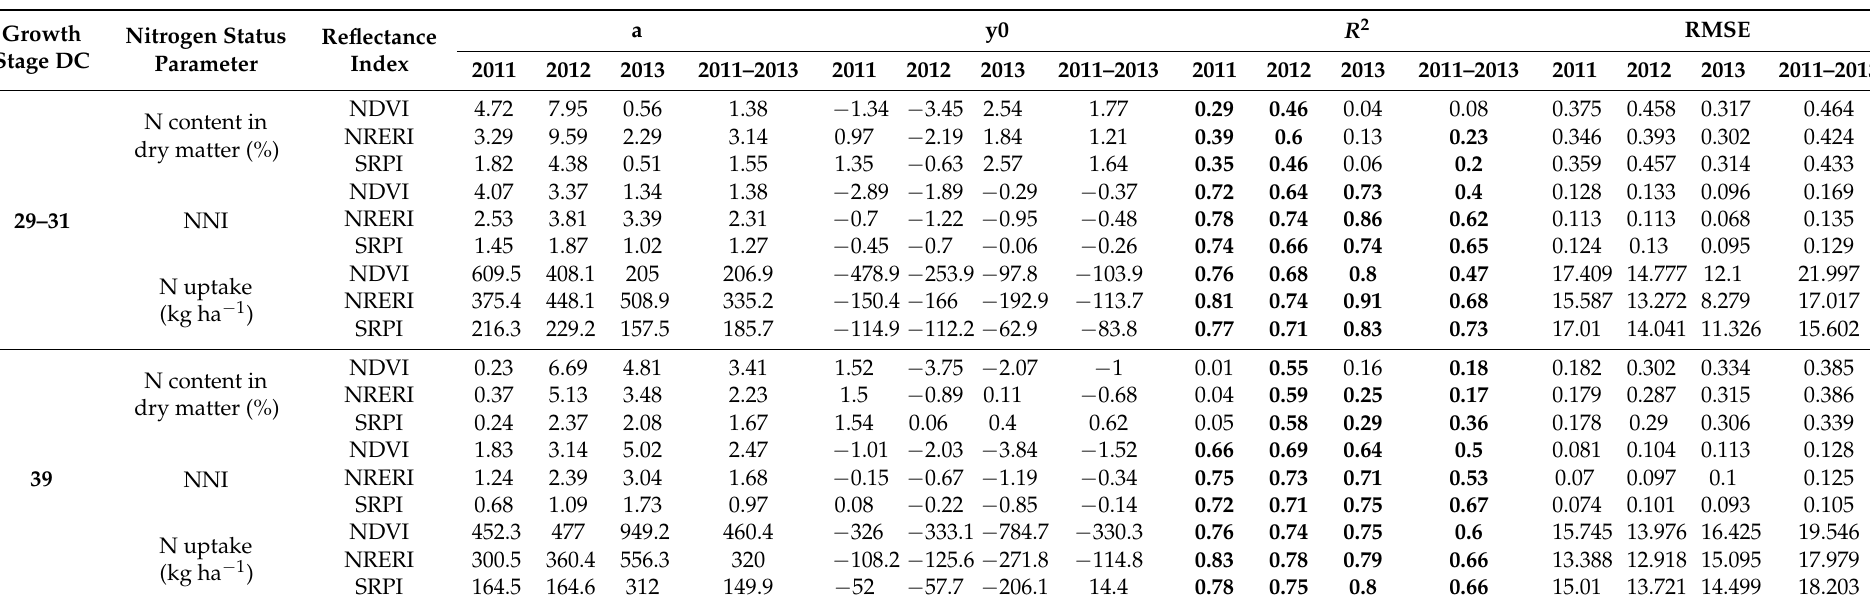
Table 3. Regression parameters of linear relationships between selected reflectance indices (y = y0 + a*x, where y is the nitrogen status parameter, a is slope of linear relationship, and y0 is the intercept), coefficients of determination ( R 2 ), and root mean square errors (RMSE) analyzed separately for individual year and all years together. Coefficients of determination significant at p < 0.05 are indicated in